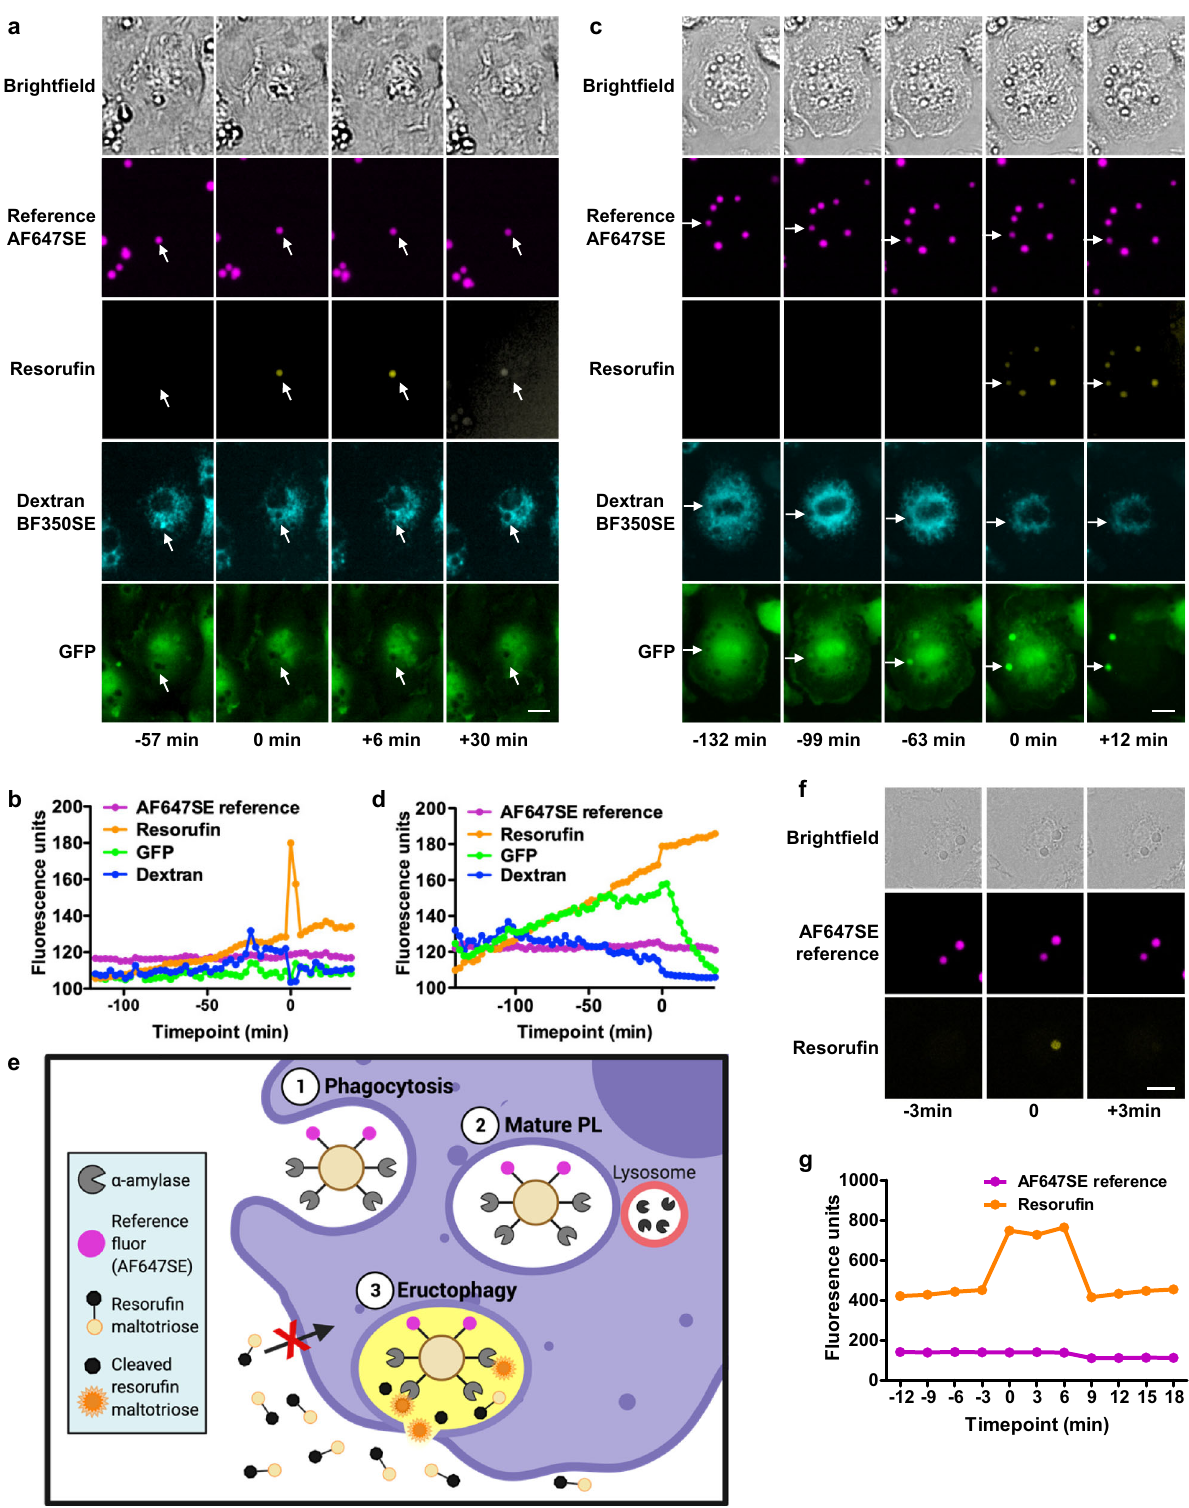
with autophagy and mTOR led us to investigate whether SNARE complexes associated with secretory autophagy play a role in eructophagy 27,28 . Initially, we examined the effects of small hydrophobic molecule inhibitors of SNARE complex zippering on eructophagy. Myricetin is an ef fi cient inhibitor of SNARE zipping through interactions of two speci fi c amino acids common to VAMP2, VAMP8 and Sec22b 29 . Indeed, myricetin signi fi cantly